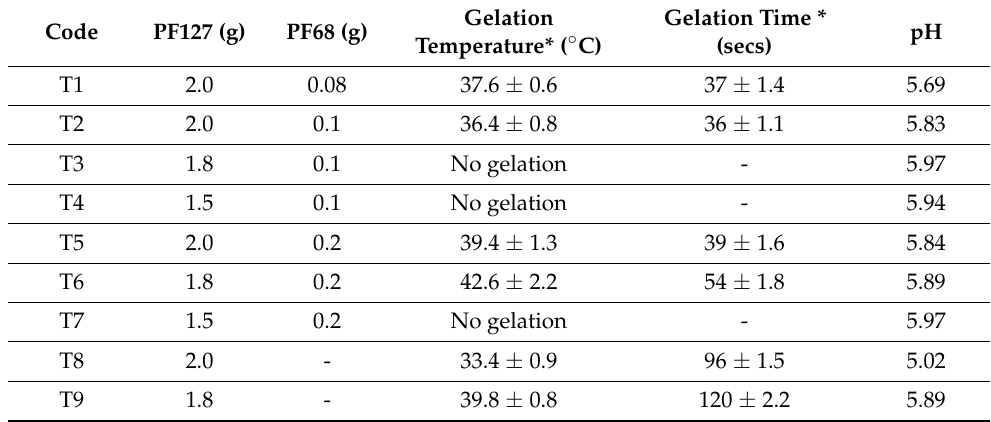
Table 3. Composition of a 10 mL thermosensitive gel and characterization results.